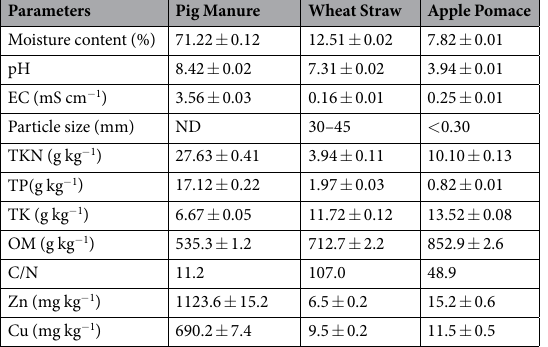
Table 2. Initial properties of composting materials. Note: Values indicate mean ± standard deviation based on the samples with four